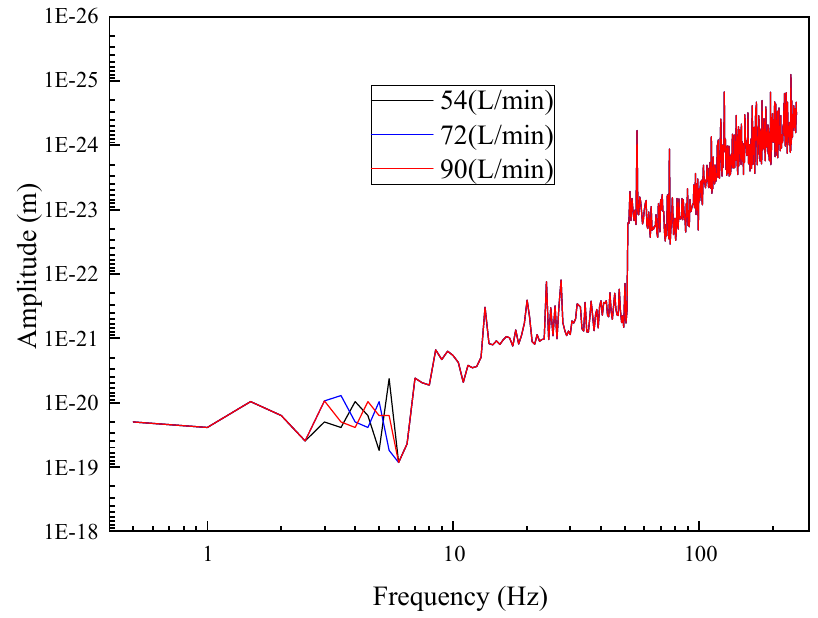
Figure 10. Vibration frequency variation of the inner leaching tubing with different water injection rates for reverse circulation.